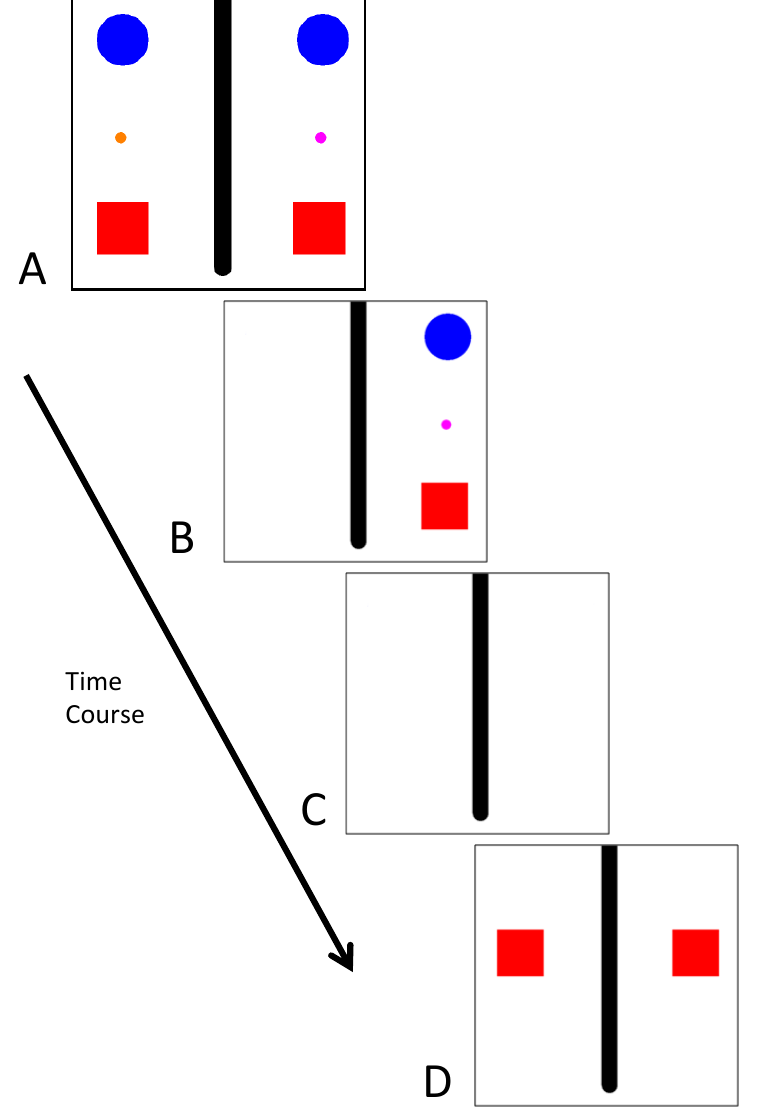
Figure 1. Outline of one possible trial. A) Initially, both sides of the screen present the Stag (rectangle) or Hare (Circle) stimuli, with random presentation of one or the other at top of screen. B) The player can choose at anytime, and here the player would choose first, at which point that side of the screen (left) goes blank. C) The SIM makes its response 1 second after the choice stimuli appear, and then its side of the screen (right) goes blank. D) Both selections then are shown at center of the screen and the player is rewarded (or not) depending on the contingency in place for that particular outcome (here, it is Stag - Stag